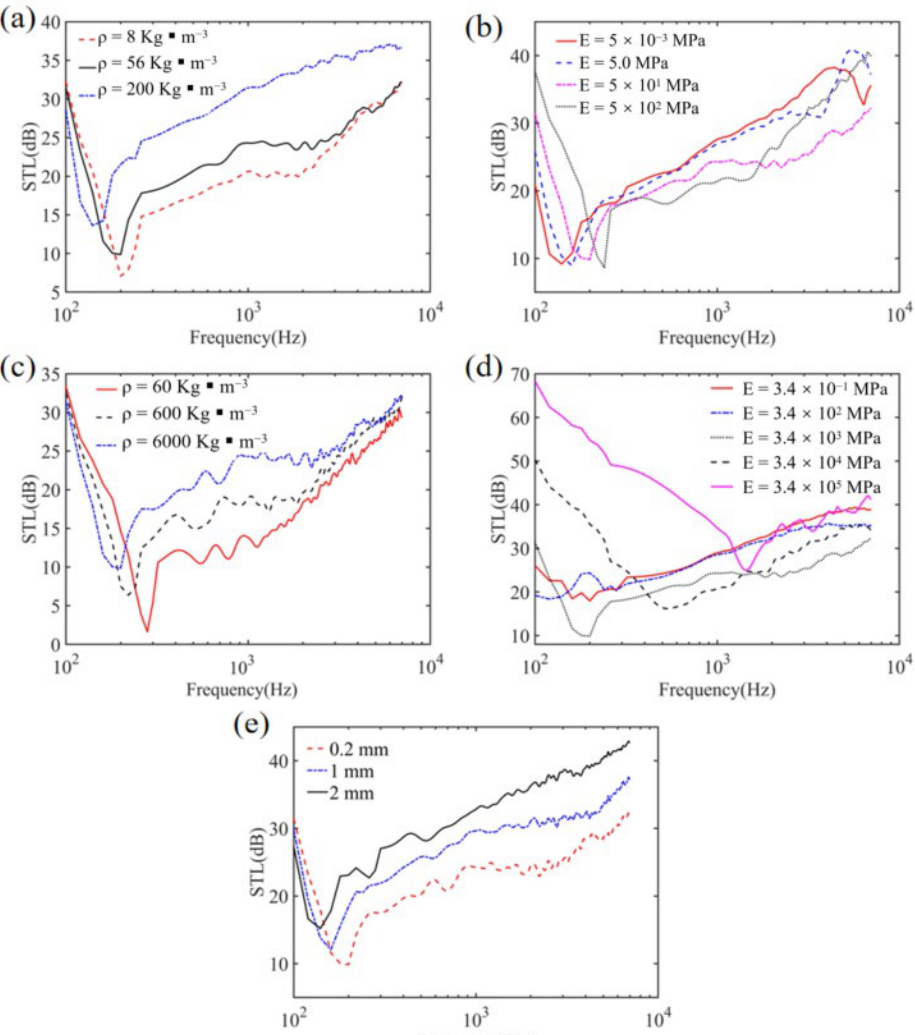
Figure 8. Parametric studies on the effects of design parameters on the STL of the CFCPs: ( a ) the effect of foam density, ( b ) the effect of foam modulus, ( c ) the effect of resin density, ( d ) the effect of resin modulus, and ( e ) the effect of fiber thickness.